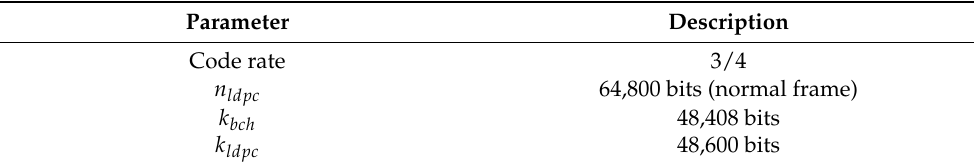
Table 2. Basic parameters of the coding